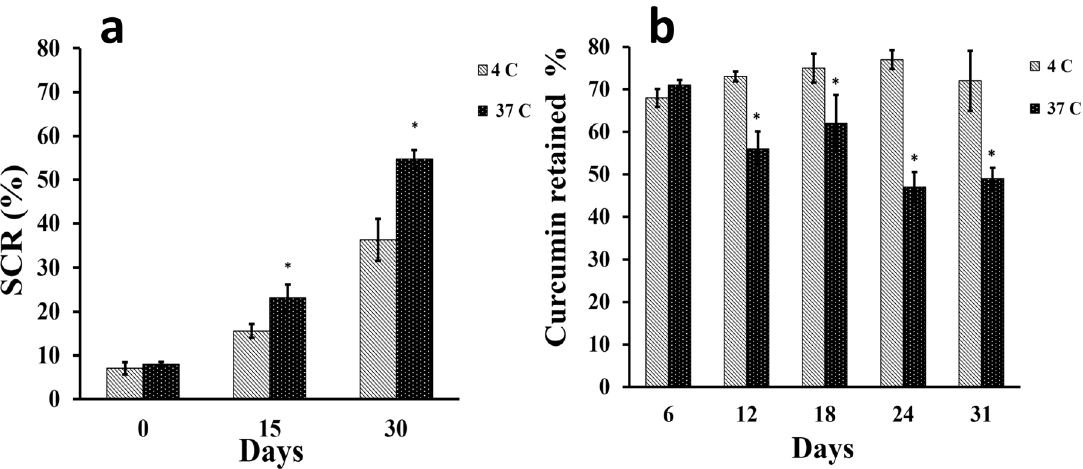
Fig. 3 The stability of the curcumin niosome nanoparticles by the measurements of the particle size by SEM at 4 and 37 °C con fi rms that the lower diameter changes at 4 °C compared to 37 °C ( a ). The